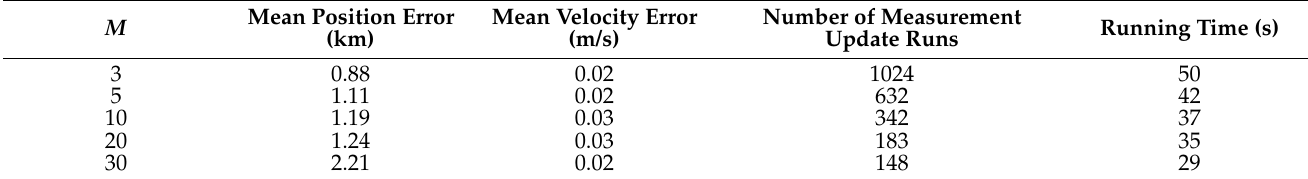
Table 7. Navigation results of the parameter-independent event-triggered mechanism with different M